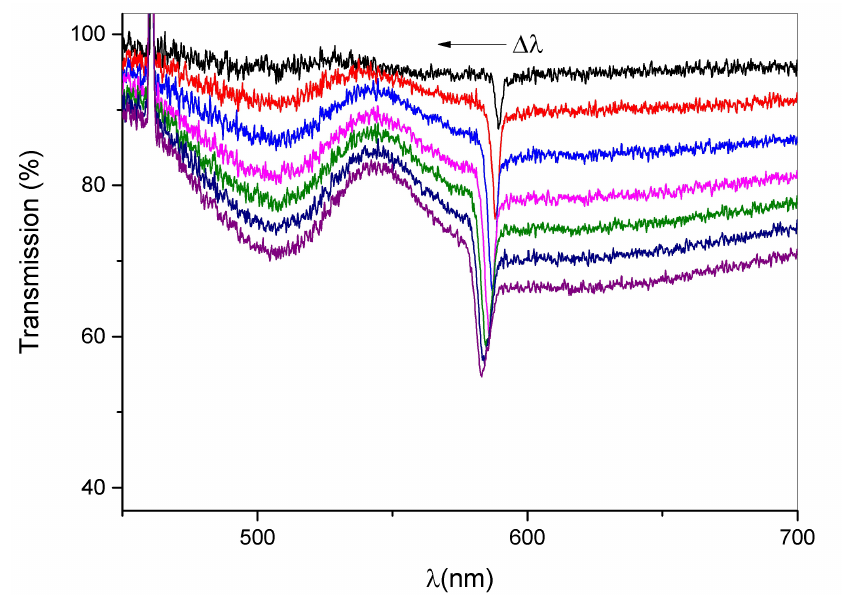
Figure 2. Real-time growth of the reflection peak under irradiation at λ = 460 nm. The acquisition time is 100 ms. The first peak (black curve) appears at t = 0.15 s. The total irradiation time is ≈ 2 s and the maximum of diffraction efficiency is obtained after ≈ 1.2 s. The blue-shift ∆ λ of the reflection peak is due to the shrinkage under irradiation.